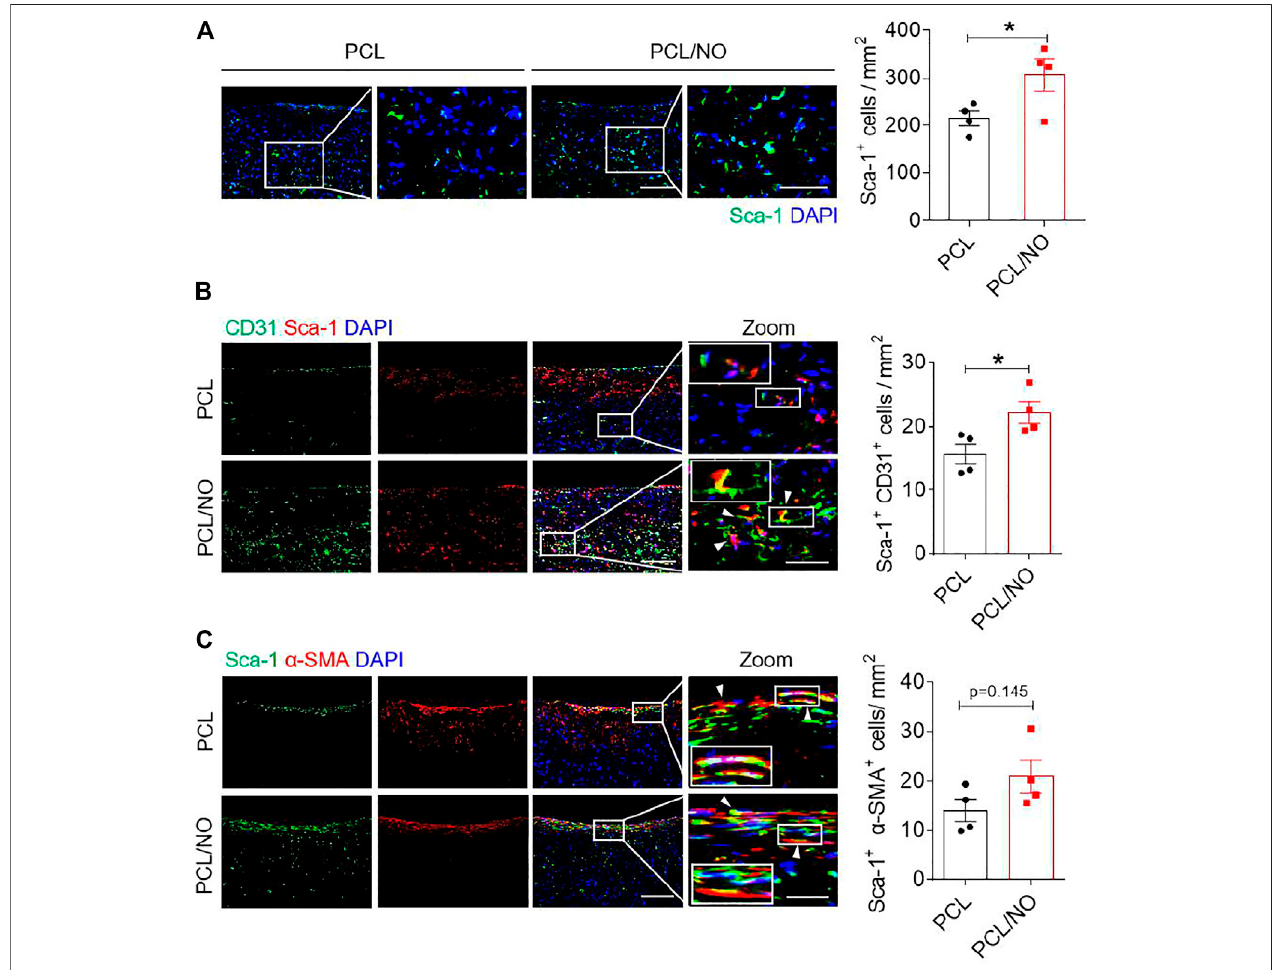
FIGURE5| Sustained NOrelease from nitrate-functionalizedSDVGspromotes Sca-1 + VPC differentiation into EC and VSMCs. (A) Immunohistochemical staining for Sca-1 + VPCs in SDVGs. Scale bar (cid:1) 100 µm. The quanti fi cation of Sca-1 + VPCs per 1 mm 2 section area is shown alongside. (B) Immunohistochemical staining for Sca-1 + (red)/CD31 + (green) ECsinSDVGsafter 3 months.Scalebar (cid:1) 100 µm.Thequanti fi cationofSca-1 + /CD31 + ECsper 1 mm 2 areaat 3 months post-implantation is shown alongside. (C) Immunohistochemical staining for Sca-1 + (green)/ α -SMA + (red) VSMCs in SDVGs at 3 months post-implantation. Scale bar (cid:1) 100 µm. Whitearrowheadsindicate double-positivestainingincells.Whiteboxesindicatethepositionoftheinsetzoomedimages. Thequanti fi cationofSca-1 + / α -SMA + VSMCs per 1 mm 2 area at 3 months post-implantation is shown alongside. Images and data are representative of n (cid:1) 4 independent experiments.